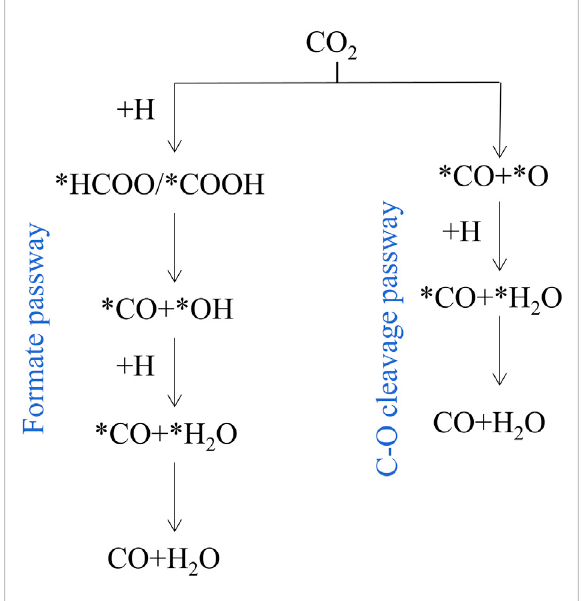
FIGURE 2 Simpli fi ed RWGS mechanism. Reproduced from Kattel et al. (2017); Copyright © 2017 (American Chemical